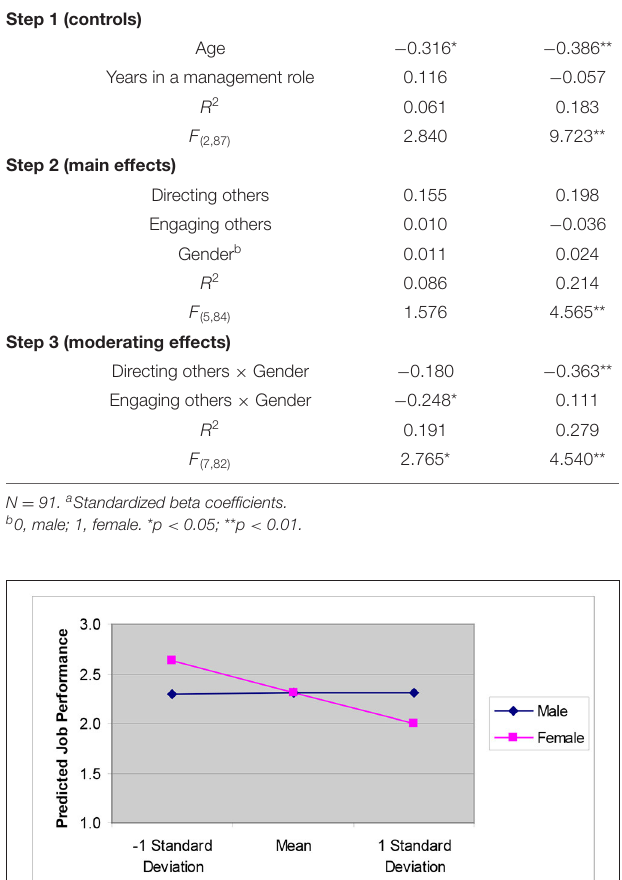
These results fail to support Hypothesis 2. The observed negative relationship for engaging others and performance for females